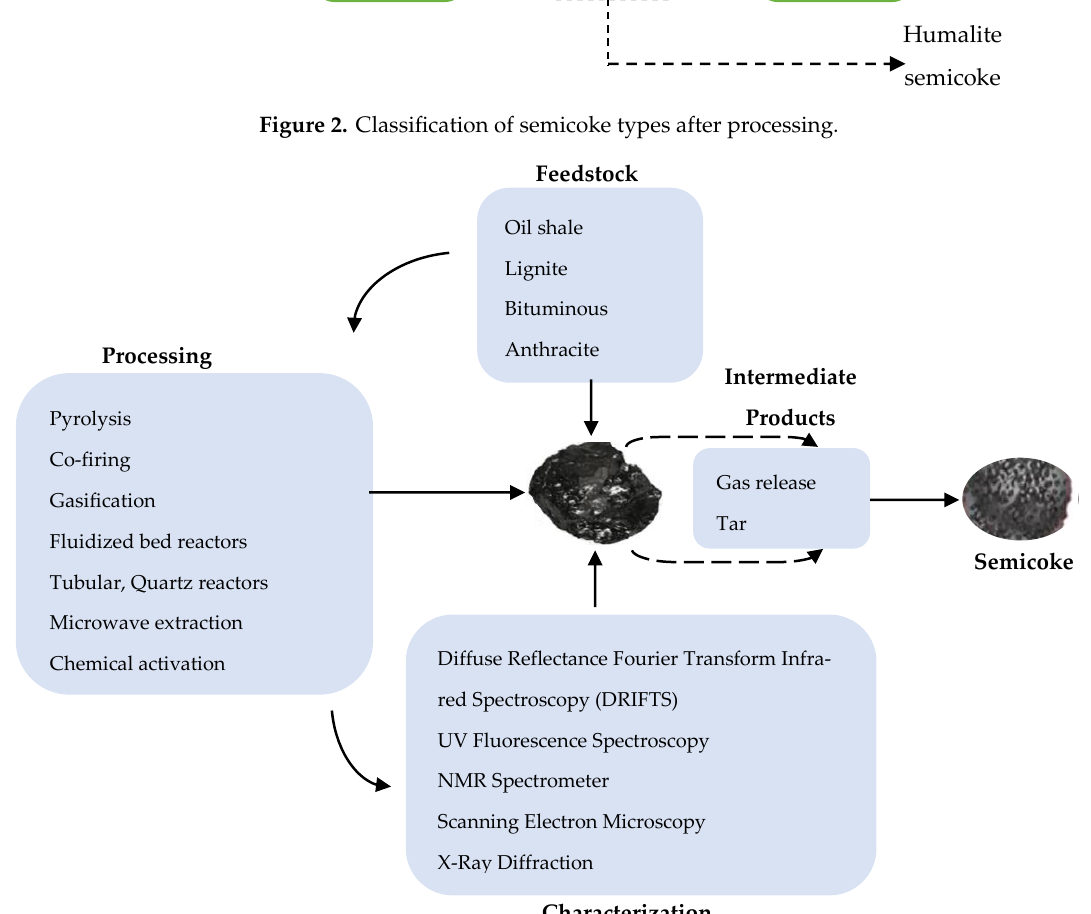
Figure 3. Flow process of some semi coke preparation factors.